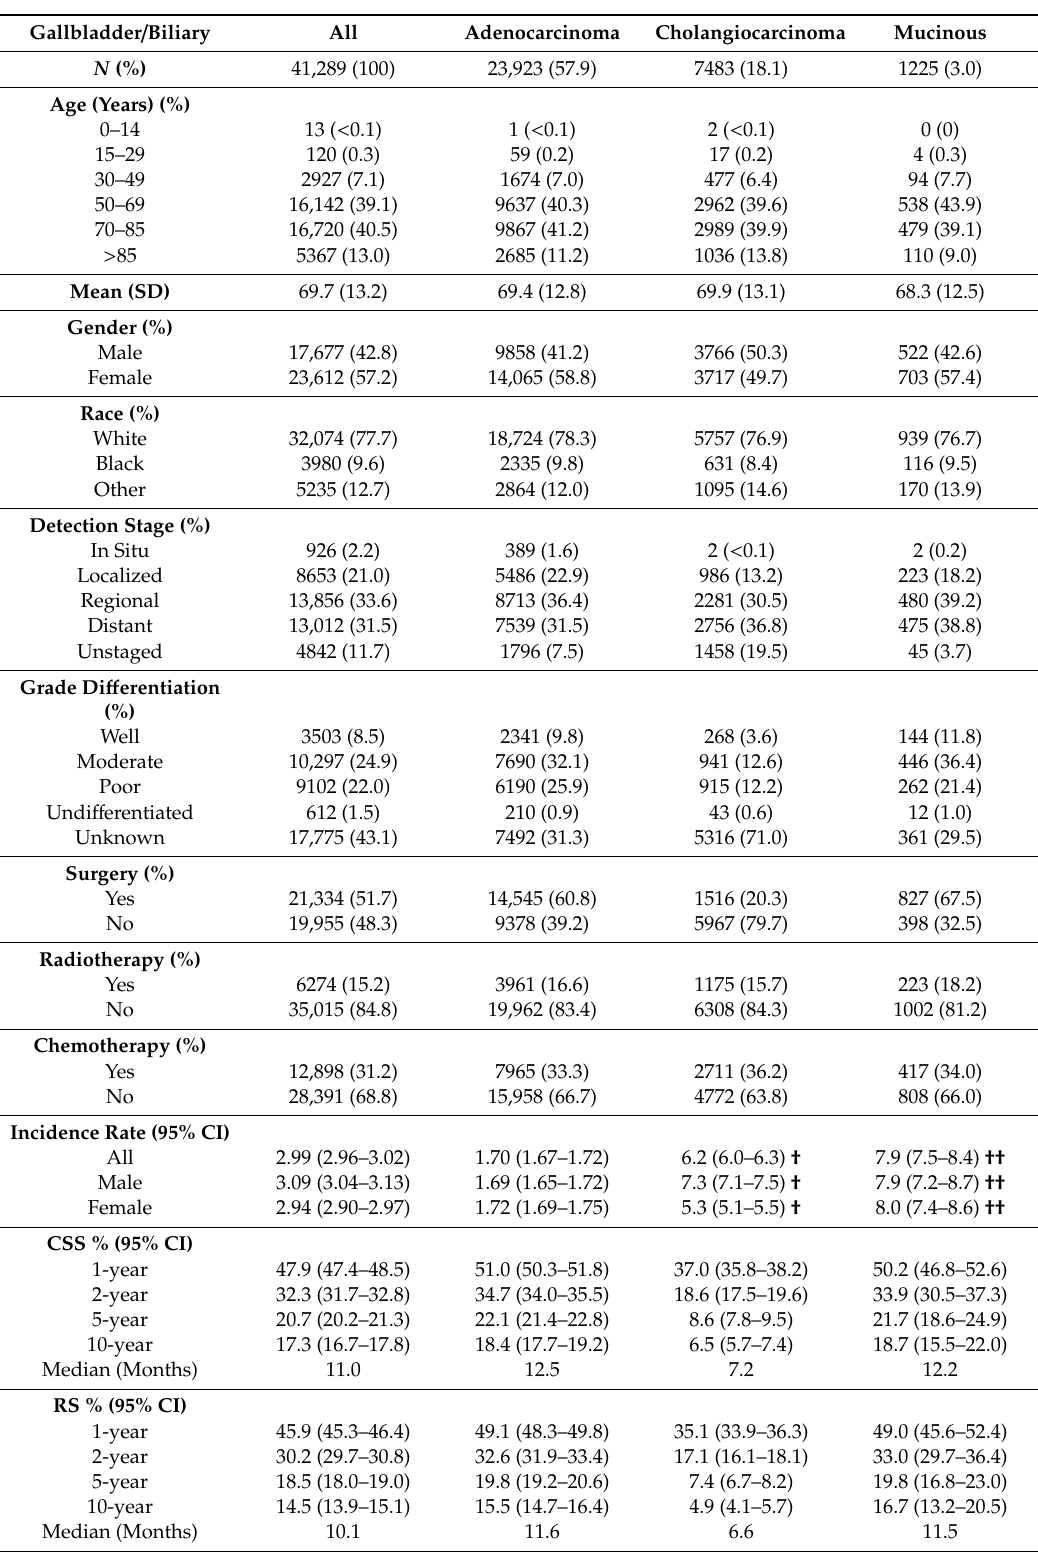
Table 15. Baseline demographics and clinical characteristics by histology for gallbladder / biliary cancers. Gallbladder / Biliary All Adenocarcinoma Cholangiocarcinoma